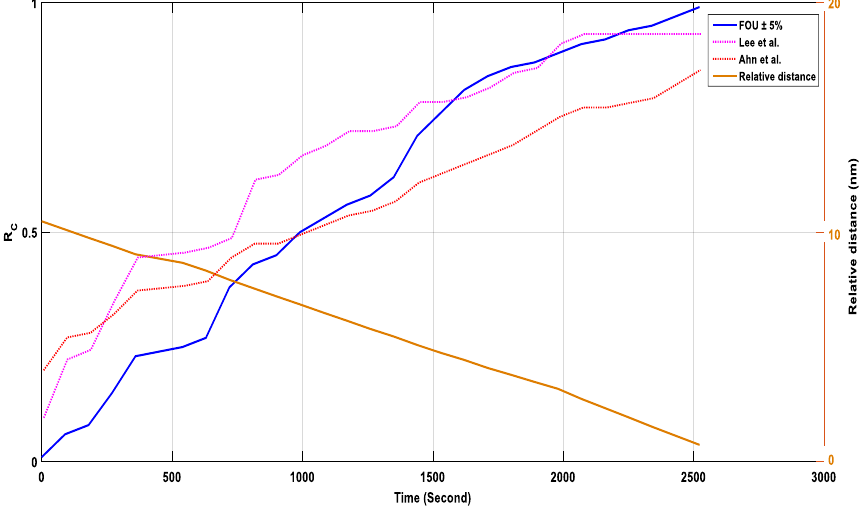
Figure 17. Comparison of the IT2FIS based on FOU size “ ± 5%” and the existing FIS.